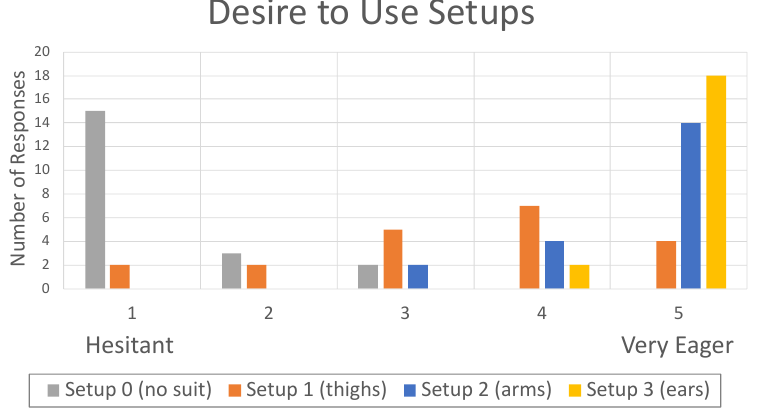
Figure 9. Desire to use the setups.